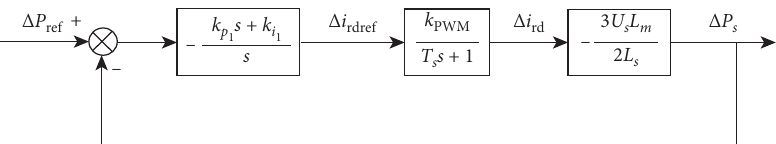
Figure 27: Active power control closed-loop.